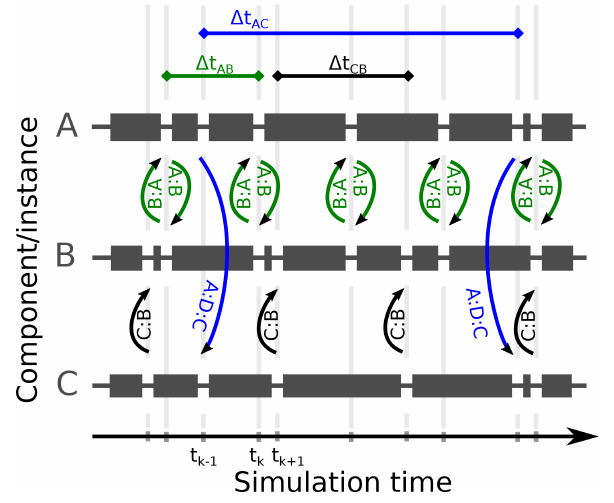
Figure 2. Scheduling of three coupled component instances A, B, C and their data exchanges according to a pairwise coupling speci- fication (see Fig. 3b); shown along a simulation time axis, which is independent of the type of (sequential or concurrent) deploy- ment. Note how each individual component instance has varying run lengths resulting from the interference of all coupling intervals with this component. The time steps of the (anonymous) scheduler component t k + n (grey bars) vary according to the interference pat- tern of all coupling intervals. Coupling specification (Fig. 3): A cou- ples bidirectionally to B at interval (cid:49)t AB (green), A couples unidi- rectionally to C via a coupler D at interval (cid:49)t AC (blue), C couples unidirectionally to B at interval (cid:49)t CB